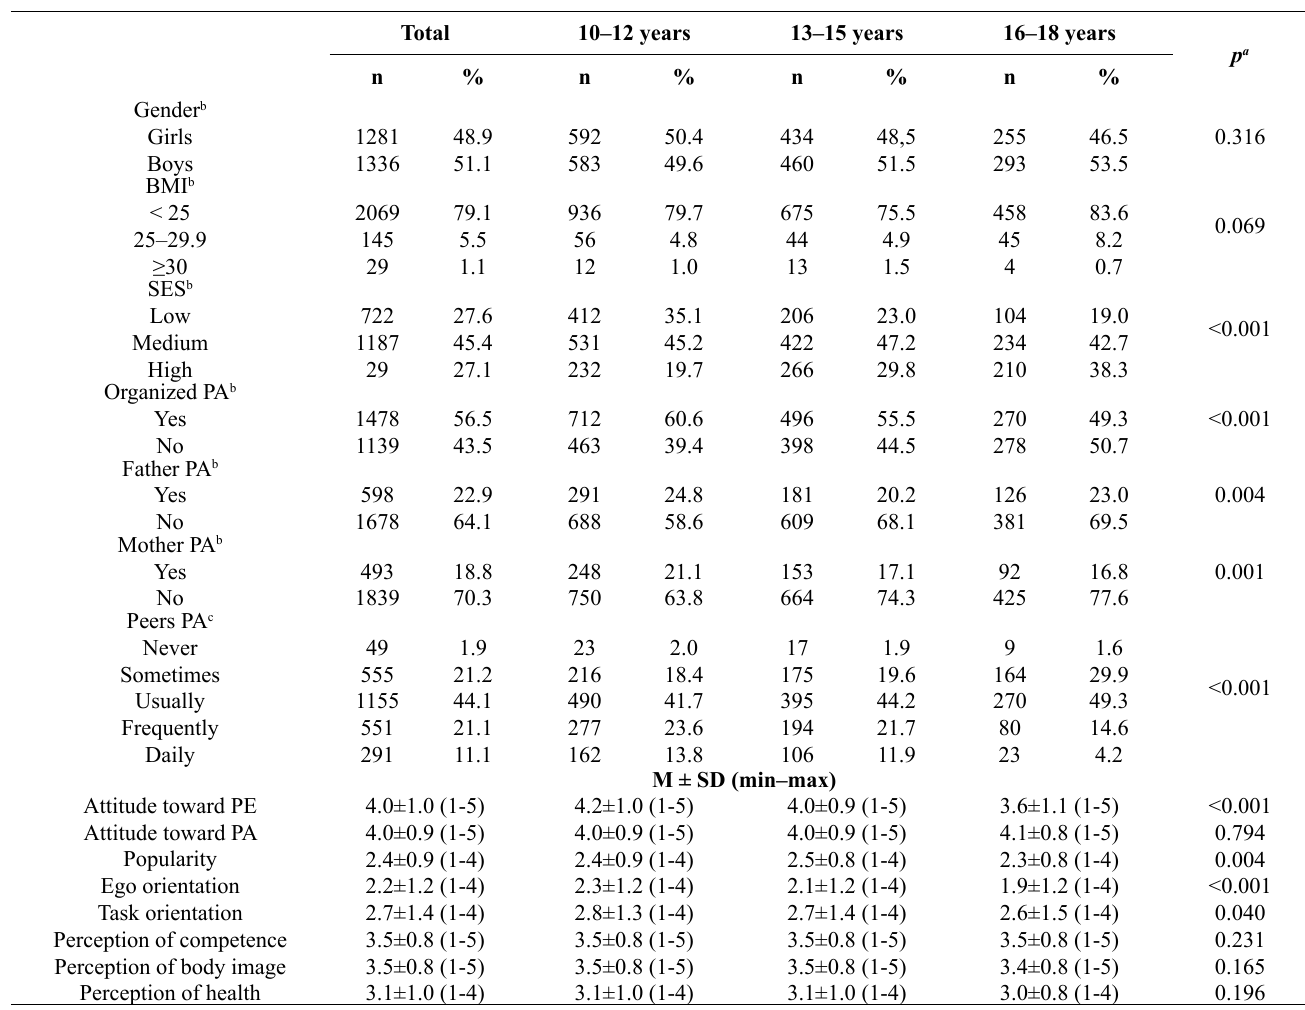
Table 1. Descriptive characteristics by age